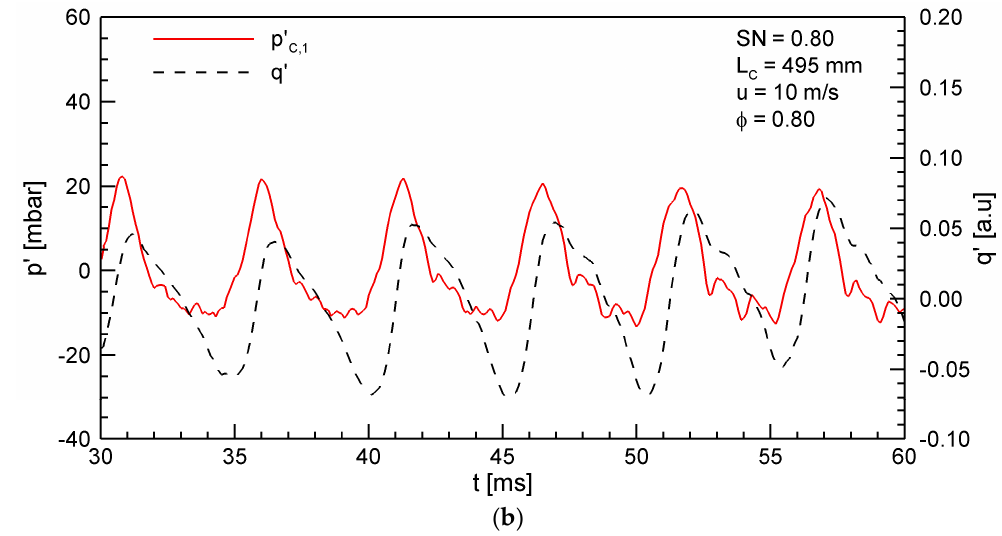
Figure 2. Time histories of the pressure fluctuation data using C 2 H 4 at L C = 495 mm, SN = 0.80, and u = 10 m/s: ( a ) ϕ = 0.60 and ( b ) ϕ = 0.80.